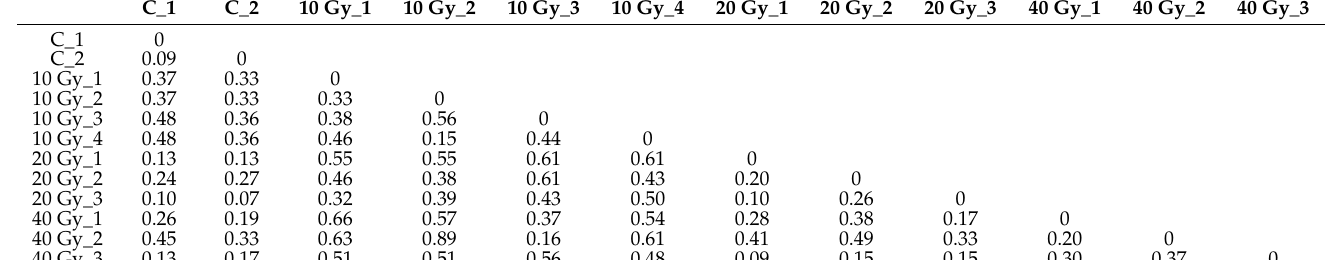
mutants and the control was found to be in the order of 0.16 (20 Gy) < 0.26 (40 Gy) and